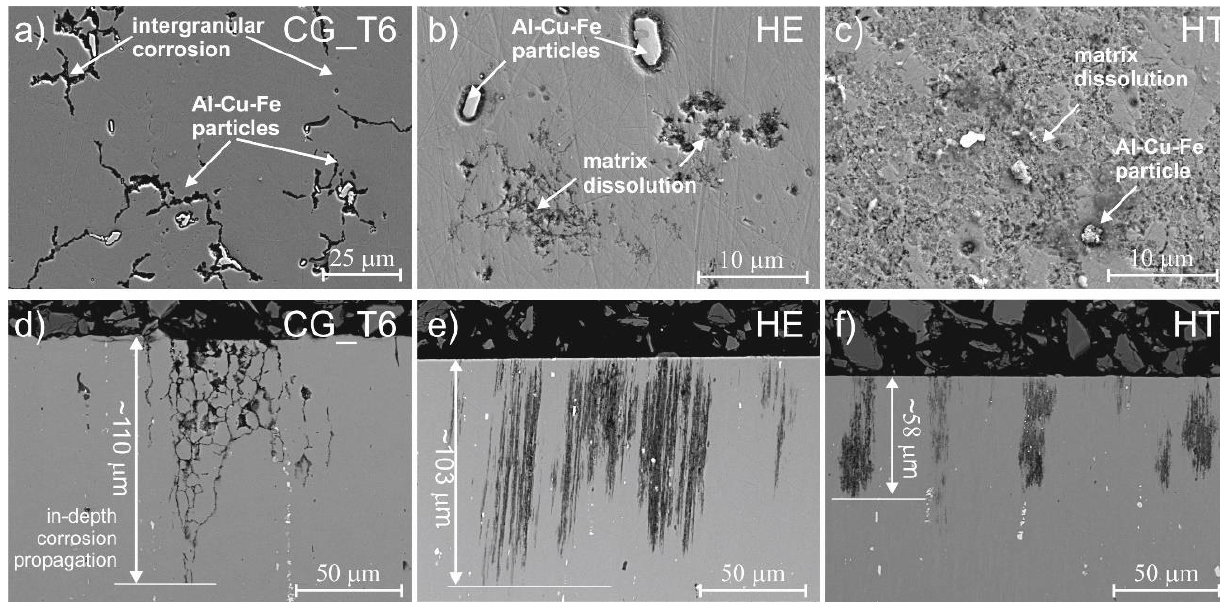
Figure 5. Post-corrosion morphology on the surface ( a – c ) and on the cross sections ( d – f ) of CG_T6, HE, and HT 7475 Al alloys after potentiodynamic polarization in aerated 0.1M NaCl. HE, and HT 7475 Al alloys after potentiodynamic polarization in aerated 0.1M